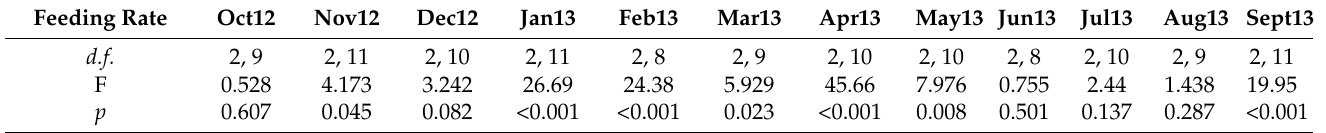
Table 3. Summary of one-way analysis of variance (ANOVA) applied to D. magna feeding rate results. Bold values stand for significant differences between